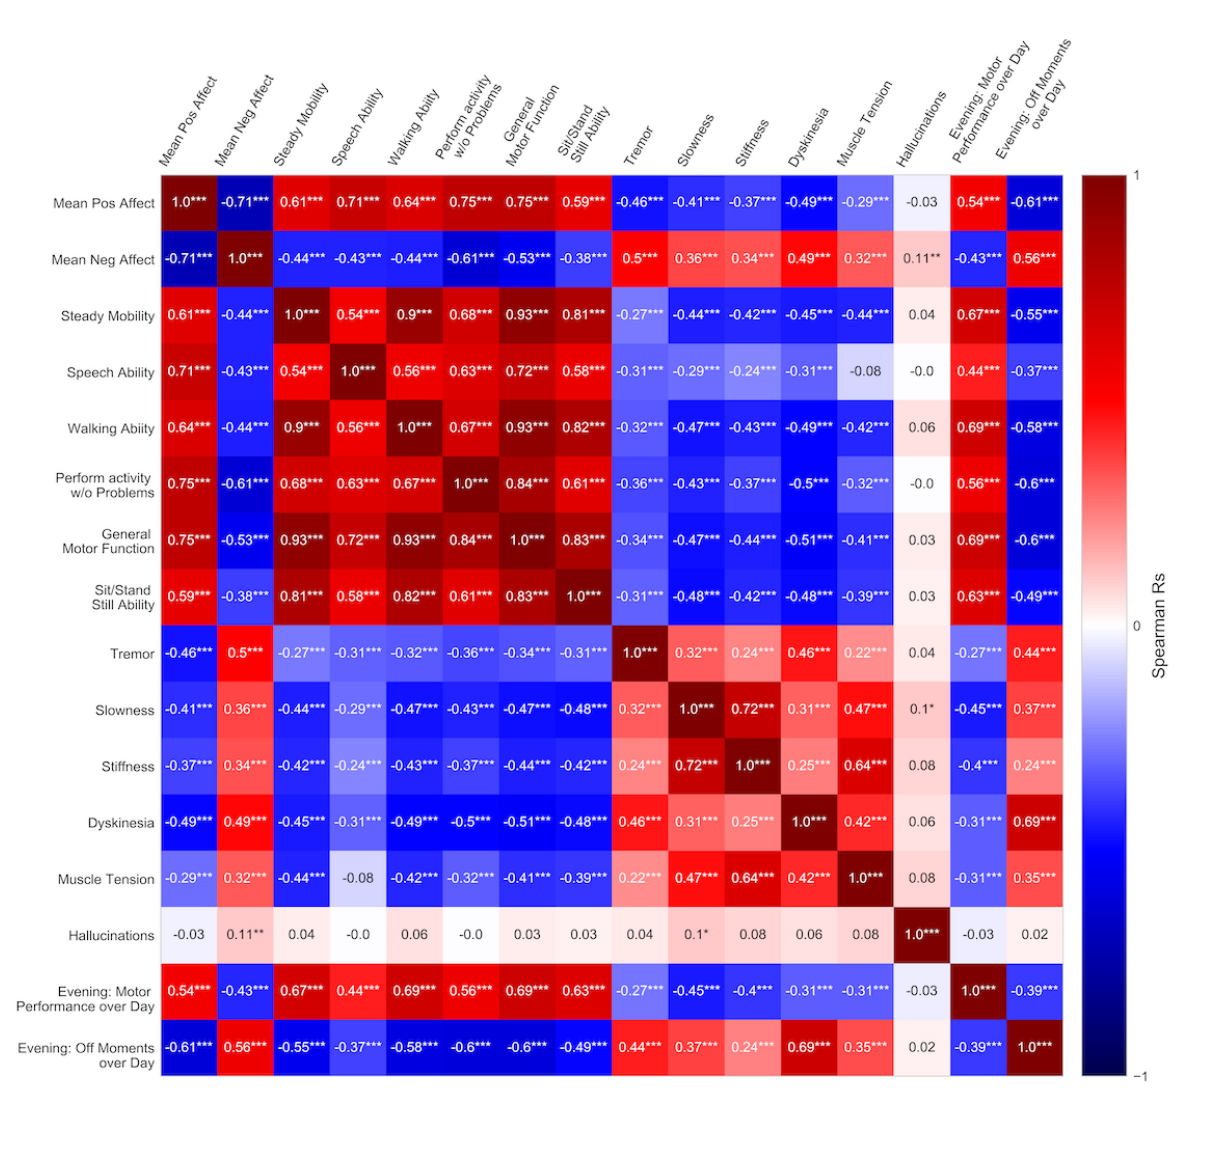
Figure 2. Correlations between items from the beep questionnaire and the evening questionnaires. We observed strong and moderate correlations between the motor performance items and mean positive and negative affect, respectively. We observed correlations between mean affect scores, motor symptoms, motor performance, and medication states, in the beep questionnaires and the evening questionnaires, in directions that were